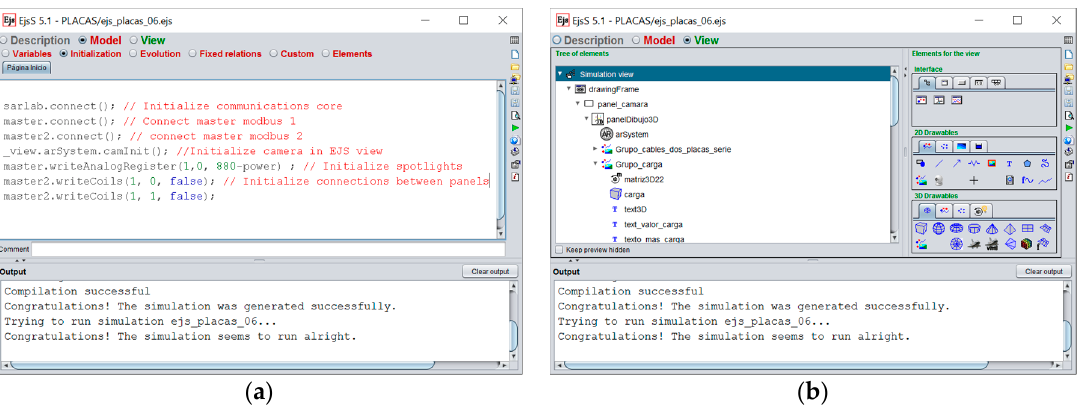
Figure 11. ( a ) Initialization code included in the HMI sources; ( b ) View panel in EJS with some graphical items defining the user interface.